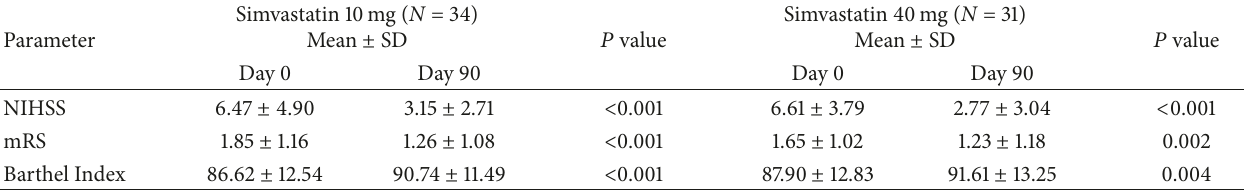
Table 5: Compare neurological outcome in patient with acute ischemic stroke 0 days and 90 days after simvastatin therapy. Parameter